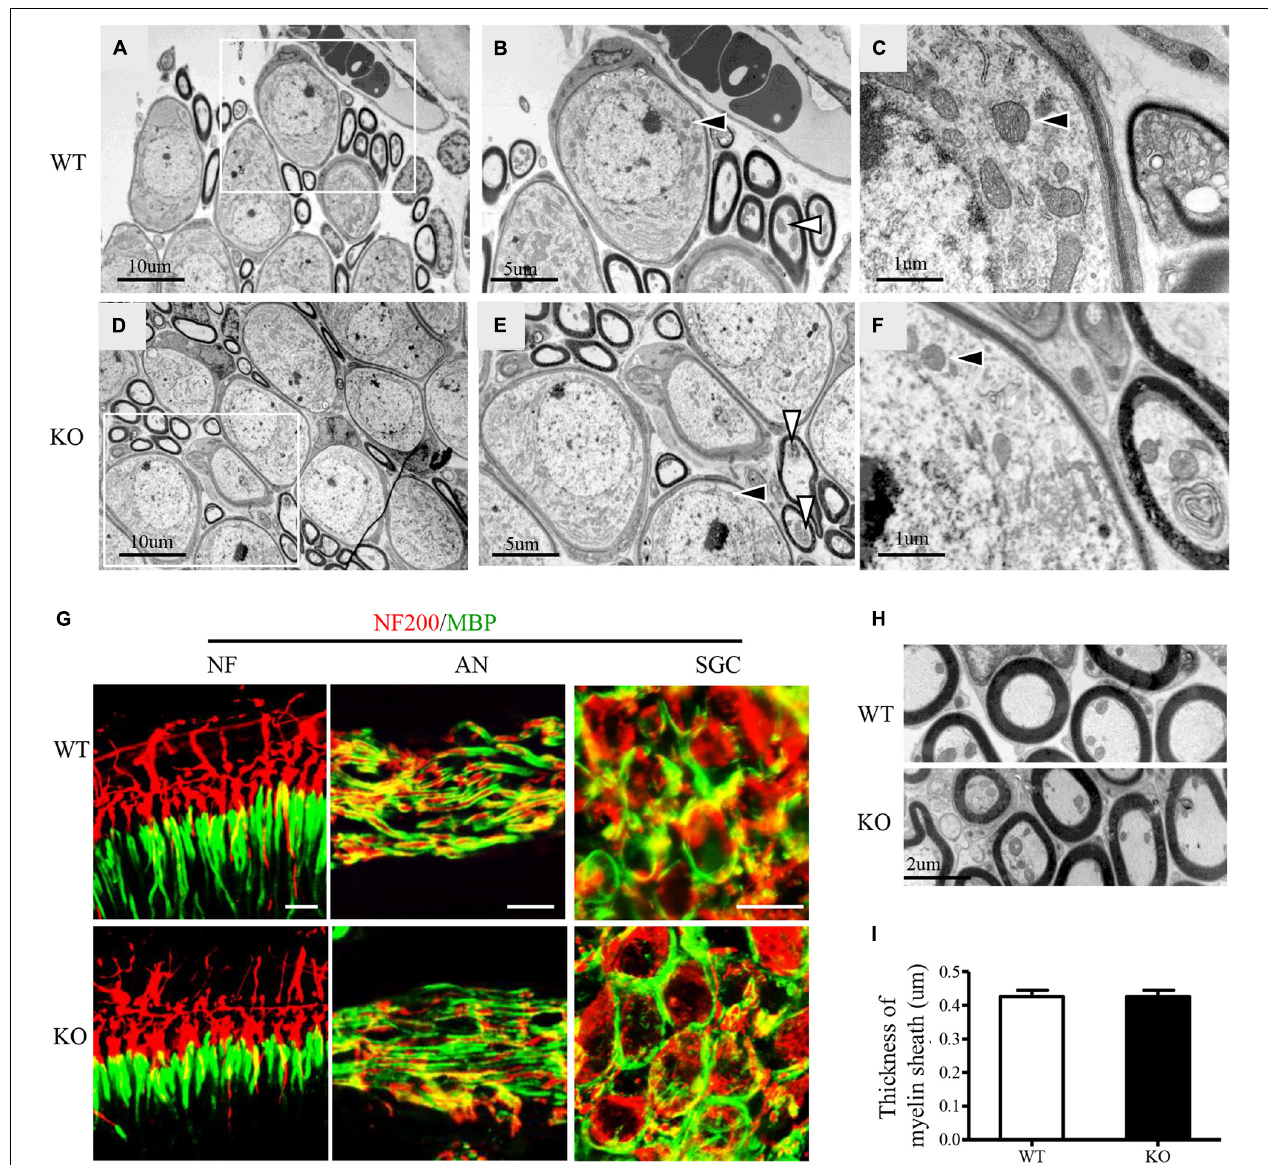
FIGURE 5 | Subcellular structures of auditory nerve and SGCs in C1ql1 WT and C1ql1 KO mice. (A–C) The subcellular structures of auditory nerve and SGCs in C1ql1 WT mice. (B) Inside the white box in (A) are auditory nerve (white arrow) and SGCs (black arrow), which are shown magnified. (C) Is a further magnification and mitochondria with normal morphology (black arrow) in SGC. (D–F) The subcellular structures of auditory nerve and SGCs in C1ql1 KO mice. (E) Inside the white box in (D) are auditory nerve (white arrow) and SGCs (black arrow), which are shown magnified. (F) is a further magnification and mitochondria with normal morphology (black arrow) in SGC. (G) Immunofluorescence staining shows normal myelin sheath in the ending of auditory nerve fibers (left), in the middle part of auditory nerve fibers (middle), and in SGSs (right) of C1ql1 WT mice and C1ql1 KO mice, respectively. Myelin sheath was marked with anti-MBP antibody (green) and auditory nerve fibers with anti-NF200 (red). Scale bar = 10 µ m. (H) Transmission electron microscopy shows myelin sheath of auditory nerve fibers in C1ql1 WT mice and C1ql1 KO mice. (I) Measured on electron micrographs, no significant difference was seen between the C1ql1 WT mice group ( n = 10) and C1ql1 KO mice group ( n = 10). Unpaired t -test, P =